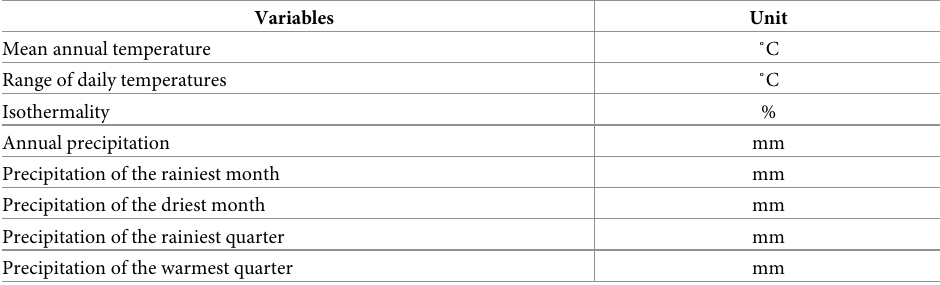
Table 2. Climate variables used in the ENM for the tiger mosquito in